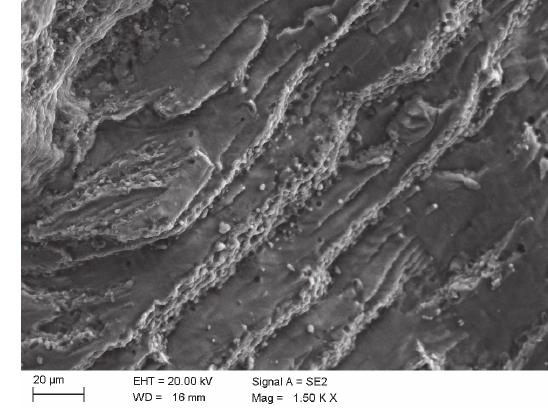
Figure 11: Transcrystalline quasi-cleavage fracture with an increases share of plastic deformation on the surface of jogs of the investigated alloy.